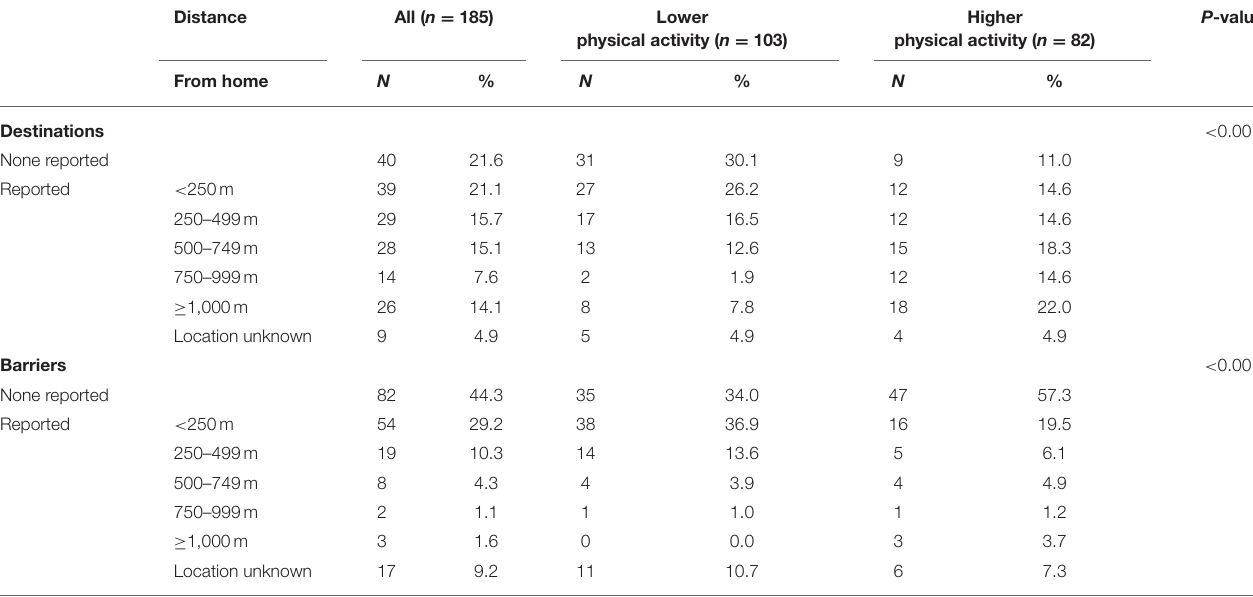
TABLE 2 | Neighborhood destinations and barriers to outdoor mobility reported and their distance to home.